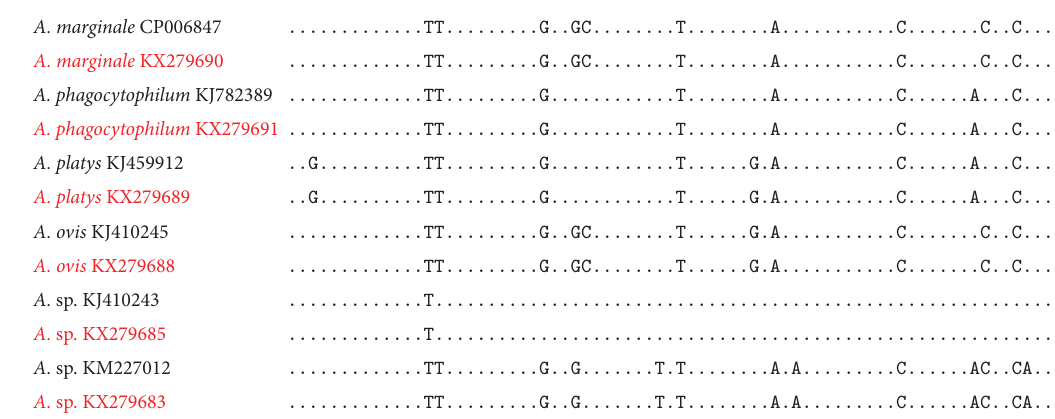
Figure2:Alignmentofthesequencesobtainedwiththe16SrRNAFRET-qPCRweusedinourstudyandthoseof Anaplasma spp.inGenBank. “.” denotes the identical nucleotide sequence to that of A. bovis . Organisms with GenBank accession numbers identified in the study are in